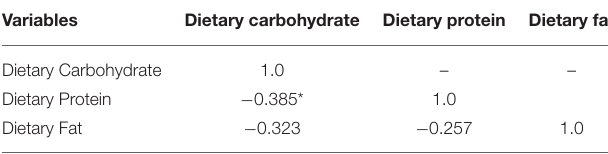
TABLE 3 | Correlation analysis between dietary carbohydrate, protein, and fat.